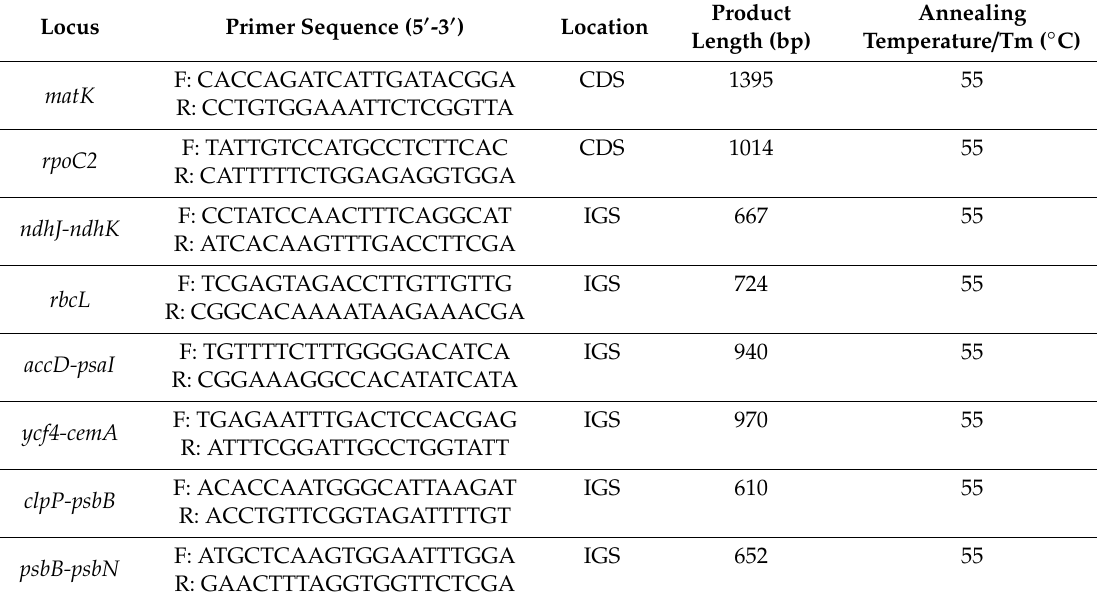
Table 4. Basic Information of Eight Chloroplast